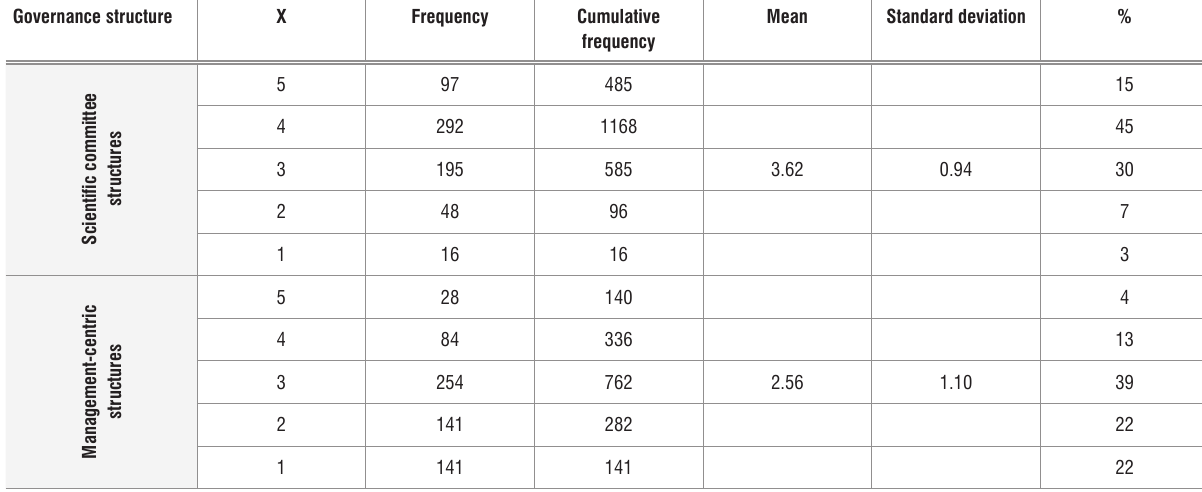
Influence of governance structures Governance